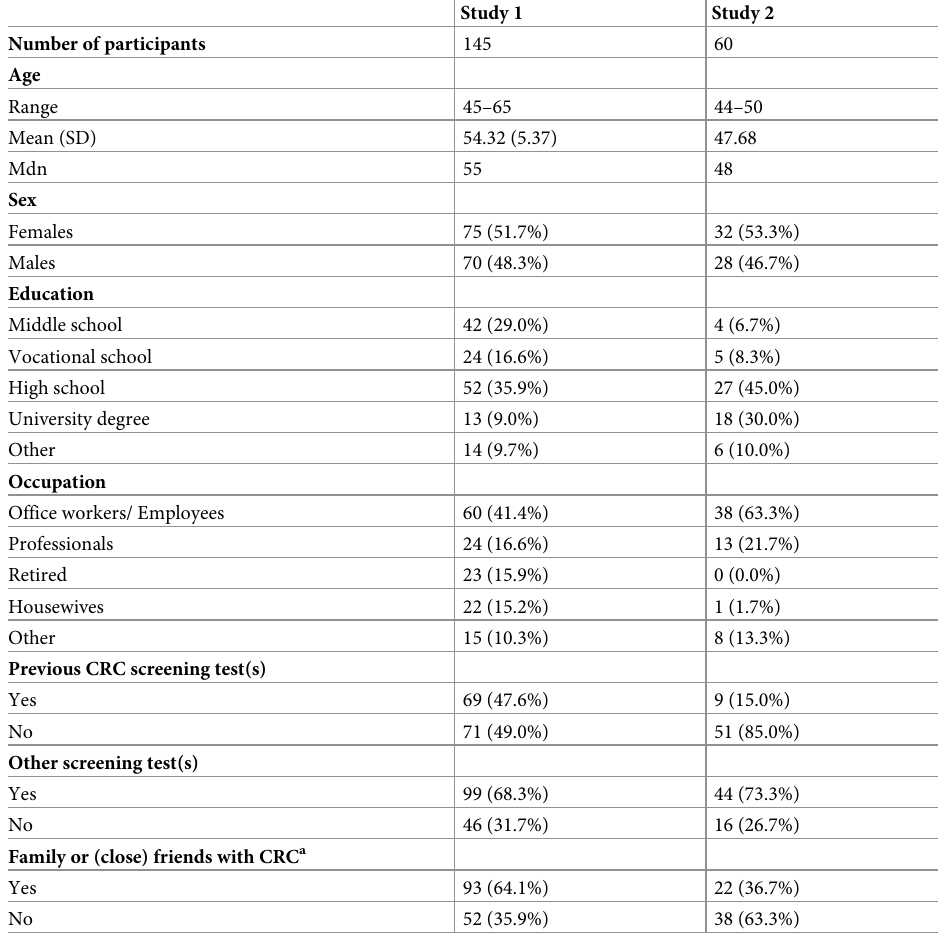
Table 1. Socio-demographic characteristics of